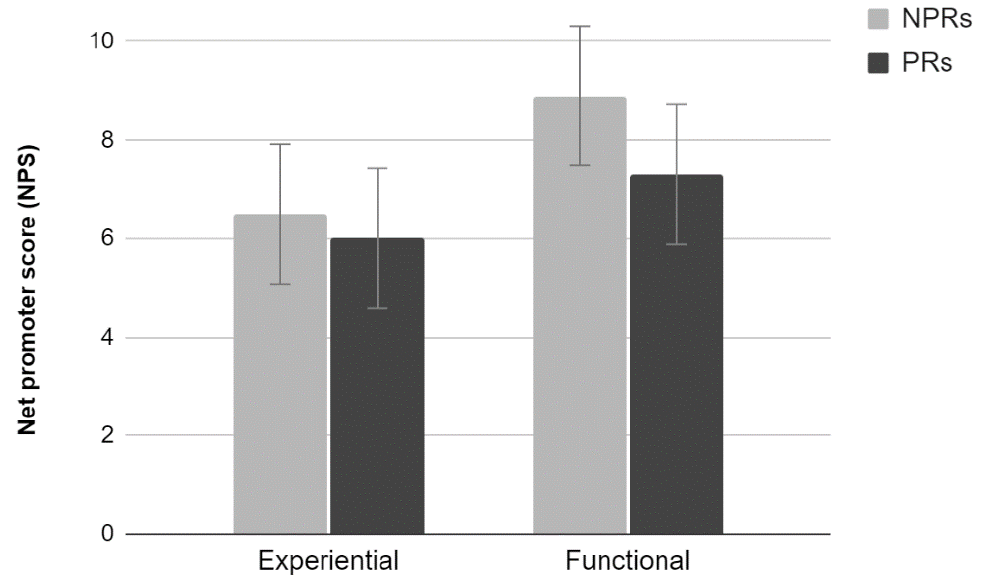
Figure 1. NPS scale score by Experience (NPRs vs. PRs) and Test (Experiential vs. Functional). Error bars denote 0.95 confidence intervals.